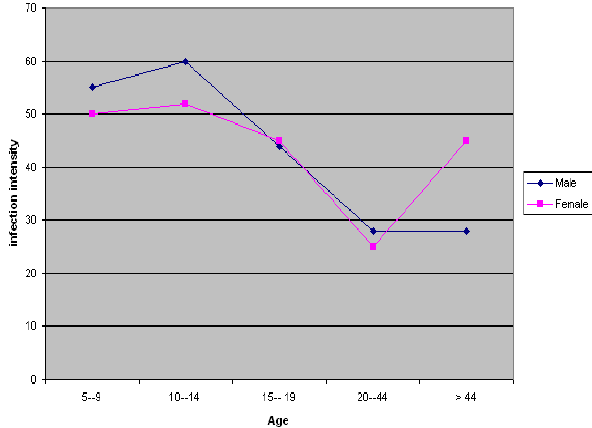
Figure 2: Intensity of infection by age and gender Water-contact